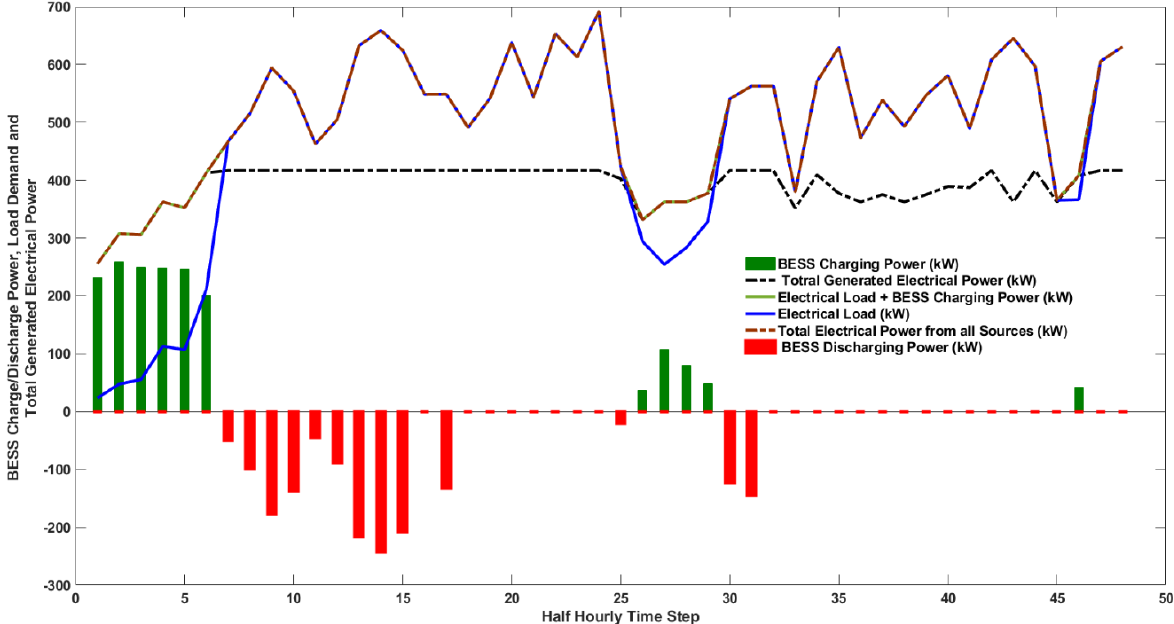
Figure 12. Total electrical power generated, real-time load demand, and BESS charge/discharge command (Scenario 3).